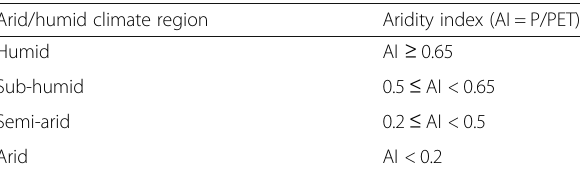
Table 1 Criteria for demarcating the arid/humid climate regions of Asia according to AI